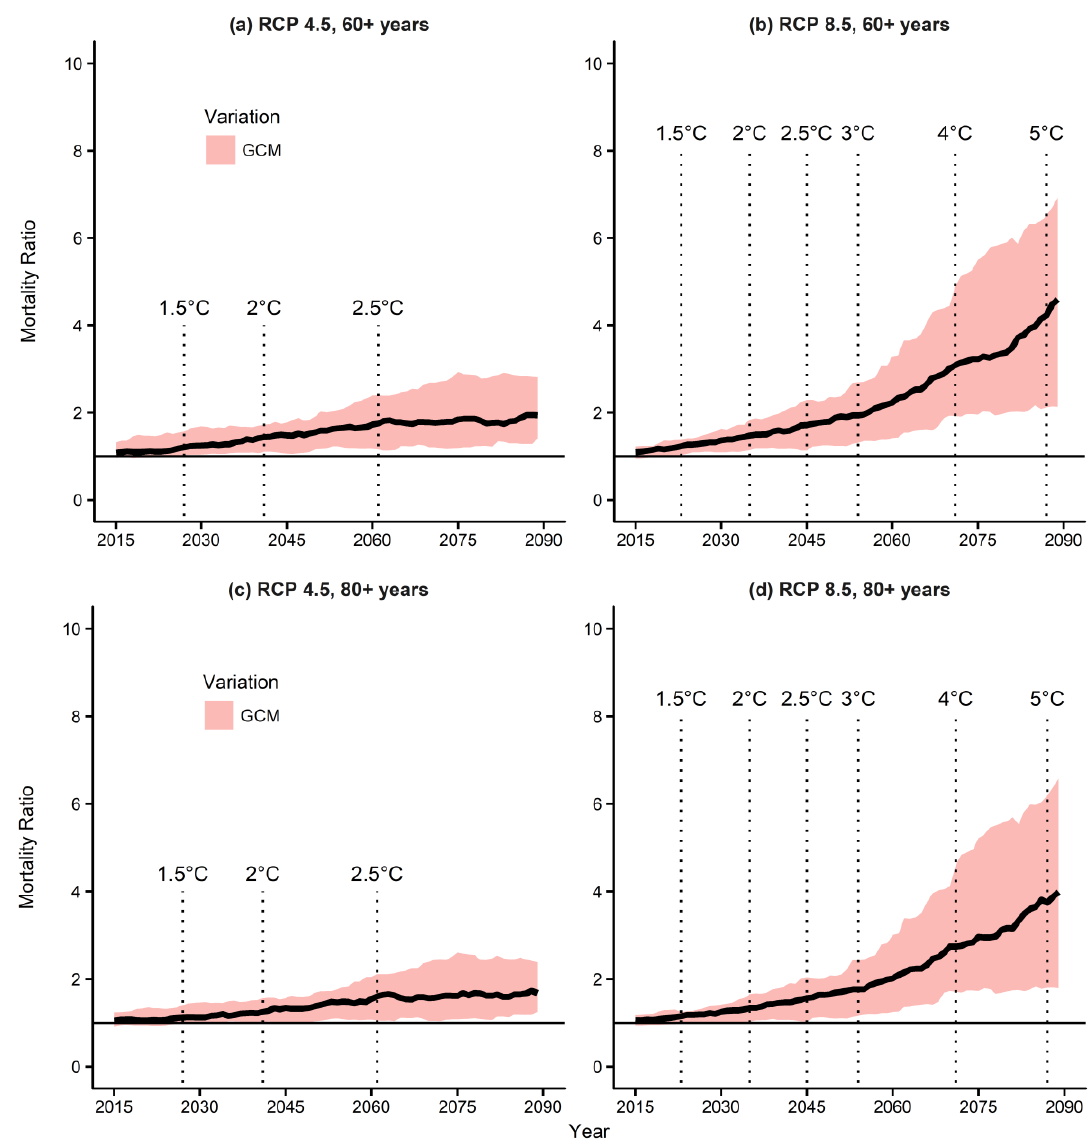
Figure 3. Mortality ratios due to temperature changes under the two RCP scenarios: ( a ) RCP 4.5, individuals aged ≥ 60 years, ( b ) RCP 8.5, individuals aged ≥ 60 years, ( c ) RCP 4.5, individuals aged ≥ 80 years, and ( d ) RCP 8.5, individuals aged ≥ 80 years. GCM, general circulation model; RCP, Representative Concentration Pathway.